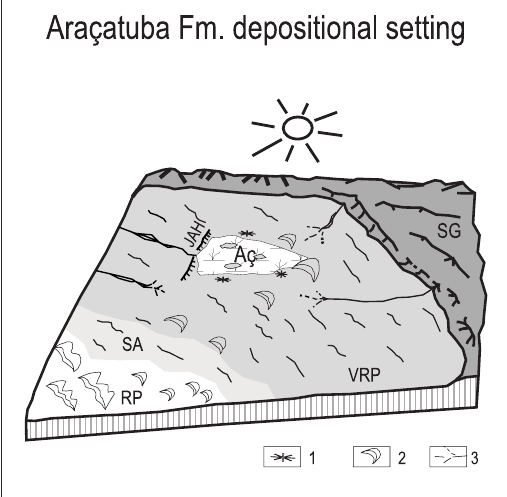
Fig. 8 – Hypothetical paleogeographic model forAraçatuba sed- imentation: a swampy area of the Bauru Basin initial sedimenta-